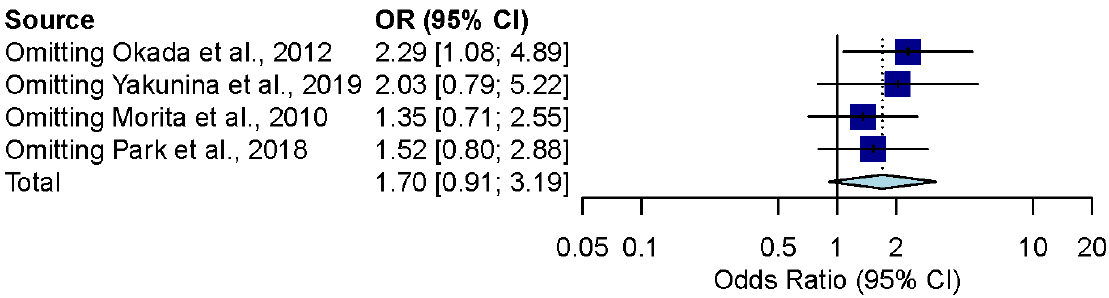
Figure 5. Influence analysis for the overall effect of diuretics alone and combination therapy in ALHL patients [9–11,21].